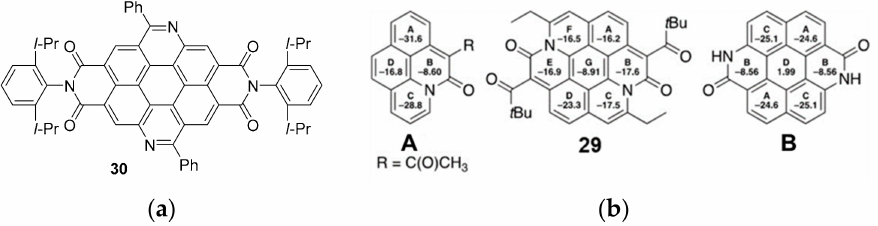
Figure 2. ( a ) structure of compound 30 ; ( b ) NICS values of 29 in toluene together with those of model compounds A and B for comparison, calculated at the B3LYP/6–31+G(d) level of theory (Reproduced with permission from S.Greßies et al., Chemistry—A European Journal; published by Chemistry Europe,